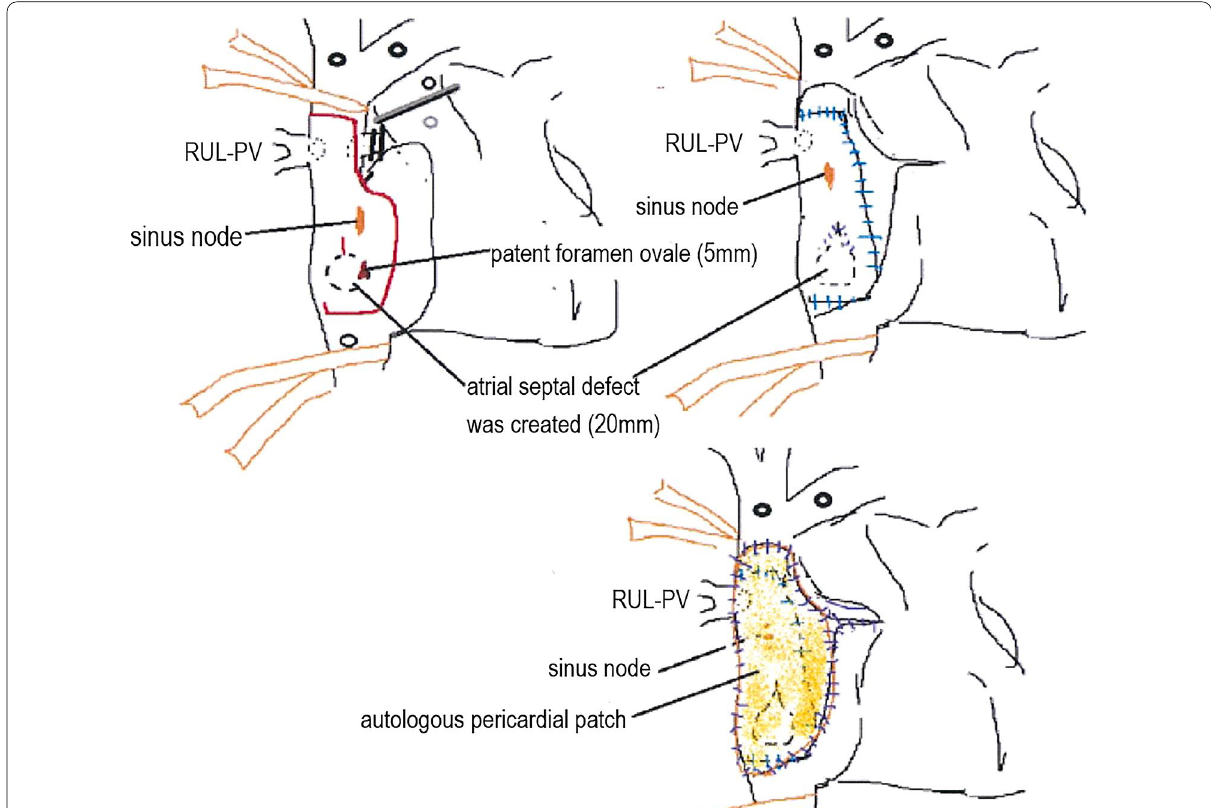
Fig. 4 Surgical schema of the correction of partial anomalous pulmonary venous connection (PAPVC) in this patient is shown. RUL-PV right-upper lobe pulmonary vein